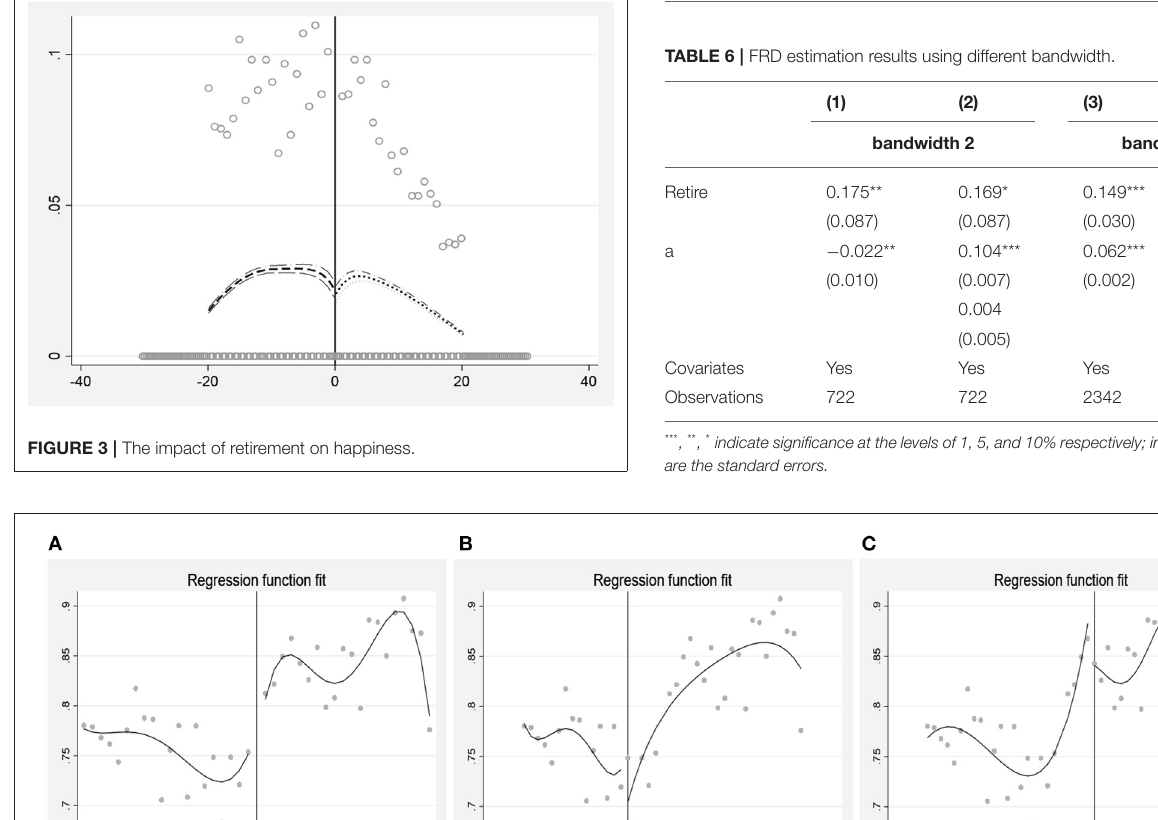
Frontiers in Public Health |